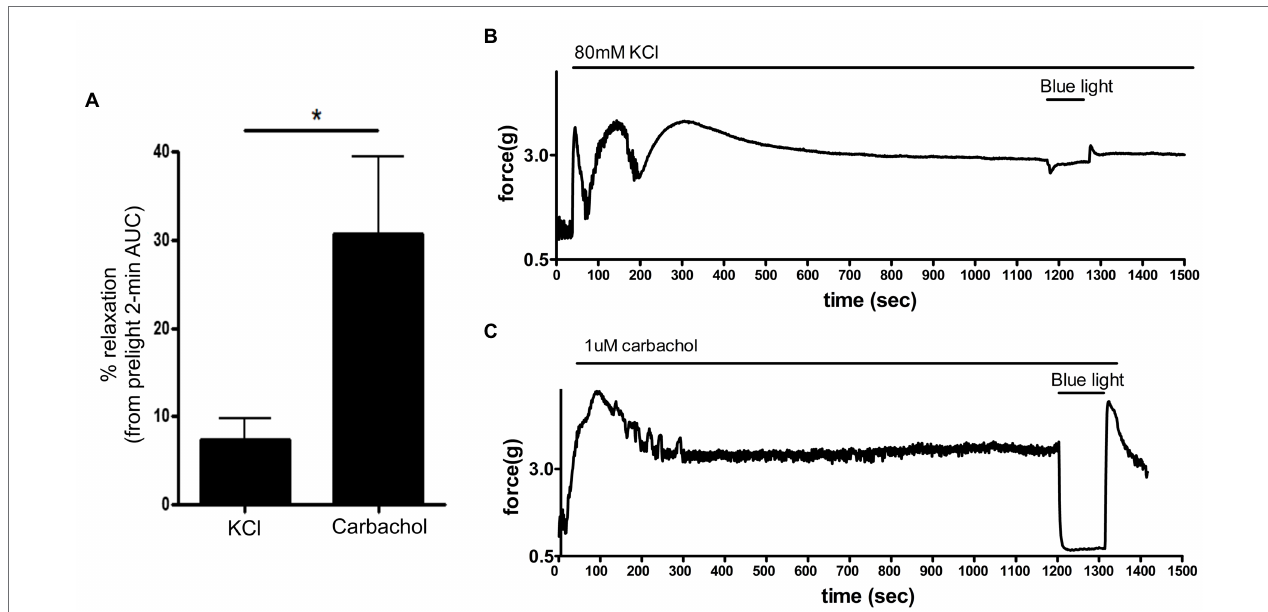
FIGURE 8 | (A) : Area under the curve analysis of blue light-induced photorelaxation of rings precontracted with either carbachol 1 μ M or KCl 80 mM. Rings precontracted with KCl exhibited significantly reduced photorelaxation in response to blue light (7.4 ± 2.3%) compared to rings precontracted with carbachol (31 ± 8.6%; * p < 0.05, n = 8 rings per group). (B,C) Representative muscle force tracings of murine colon rings pretreated with TTX 1 μ M, 9 -cis retinal 28 μ M + GRK2 inhibitor 20 μ M and precontracted with either carbachol 1 μ M or KCl 80 mM and subsequently exposed to blue light (435 nm λ ) in wire myography